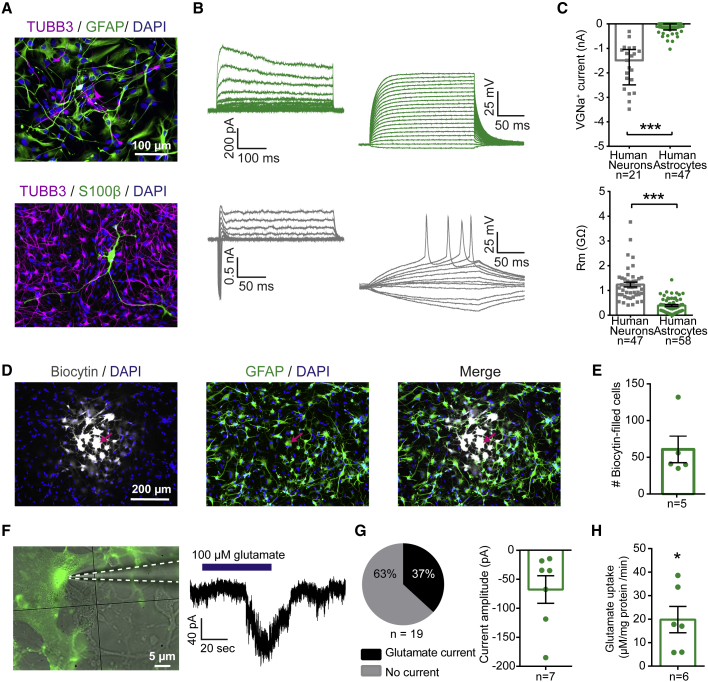
Functional Characteristics of Cortically Derived iPSC-Astrocytes(A) Example GFAP+ astrocyte culture (55 days; top) and TUBB3+ neuronal culture (100 days; bottom). Cultures were highly enriched for their respective cell type, but low numbers of TUBB3+ cells were observed in astrocyte cultures, and low numbers of S100β+ astrocytes were observed in long-term neuronal cultures.(B) Example leak-subtracted current responses (left) and voltage responses (right) from an iPSC-astrocyte (99 days; top) and an iPSC-neuron (91 days; bottom).(C) Comparison of peak voltage-gated sodium (VGNa+) currents (top) and membrane resistance (Rm; bottom) between astrocytes and neurons. Sample sizes represent individual cells recorded from 14 cultures across four cell lines (astrocytes 97 ± 3.5 days) and 13 cultures across three cell lines (neurons 92 ± 3.3 days).(D) Example gap-junction connected iPSC-astrocytes revealed by filling a single astrocyte with biocytin (arrow; 103 days).(E) Number of gap-junction connected cells quantified from immunolabeling with streptavidin (n = 5 patched astrocytes from a 103-day-old culture).(F) Example whole-cell patch-clamp recording from an iPSC-astrocyte (123 days; left) showing an inward current in response to bath application of glutamate (right), consistent with uptake (Dallas et al., 2007).(G) Proportion of iPSC-astrocytes that showed a significant glutamate-uptake current (left; n = 19 astrocytes recorded from eight cultures across four cell lines, 95 ± 5.3 days; see Supplemental Experimental Procedures). Current amplitudes are shown for the astrocytes that exhibited glutamate uptake (right).(H) Glutamate uptake capacity of iPSC-astrocytes assessed by an enzymatic absorbance assay (n = 6 cultures comprising two cultures from each of three cell lines, 73 ± 6.7 days; see Supplemental Experimental Procedures). ∗p < 0.05, ∗∗∗p < 0.001.